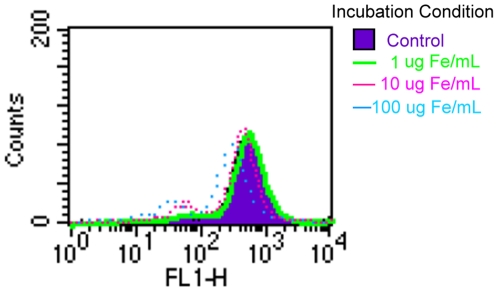
The MMP of macrophages treated with SPIO particles was measured by fluorescent intensity of the FL-1 channel.There was a leftward shift of the fluorescent intensity after the cells had ingested the SPIO particles, and this response occurred in a dose-dependent manner.